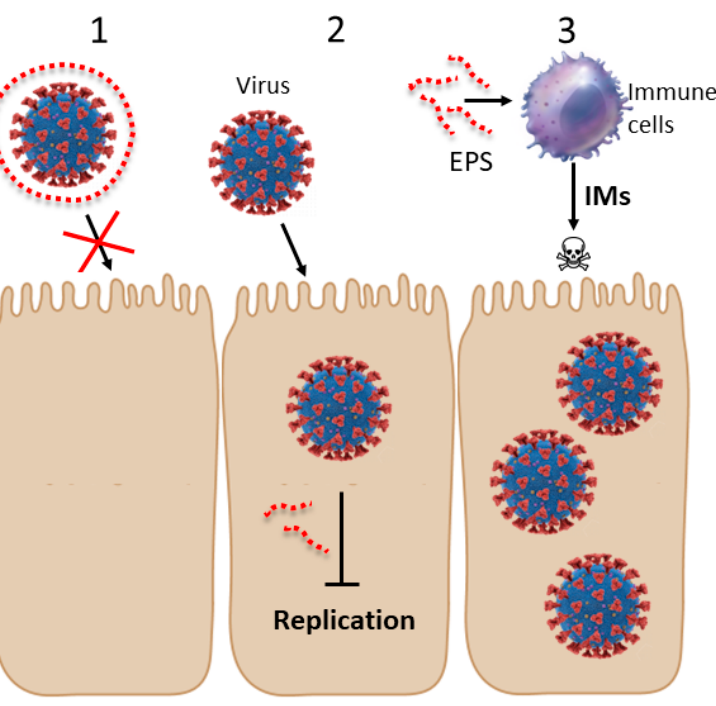
Figure 1. Mechanisms of antiviral action of microbial exopolymers. EPSs can exert their antiviral activity via different mechanisms. Virucidal agents act by inactivating viruses. Inactivation can occur not only by damaging the virions, but also by blocking them and impeding the adsorption of virions to cells (red cross). Some EPSs can wrap the virions via electrostatic interactions, thus preventing viral adsorption and, therefore, exerting a virucidal effect ( 1 ). Other EPSs exert an antiviral effect allowing the viral entry but later impeding the viral replication. Therefore, antivirals inhibit replication of viable viruses in the cells ( 2 ). EPSs can also exert antiviral effect by activating immune cells and inducing them to secrete immunomodulators (IMs) and to kill virus-infected cells ( 3